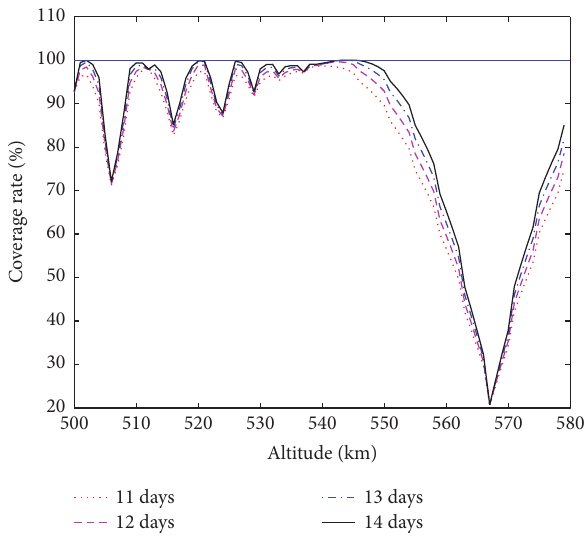
Figure 12: The relationship between the coverage percentage and the altitude for